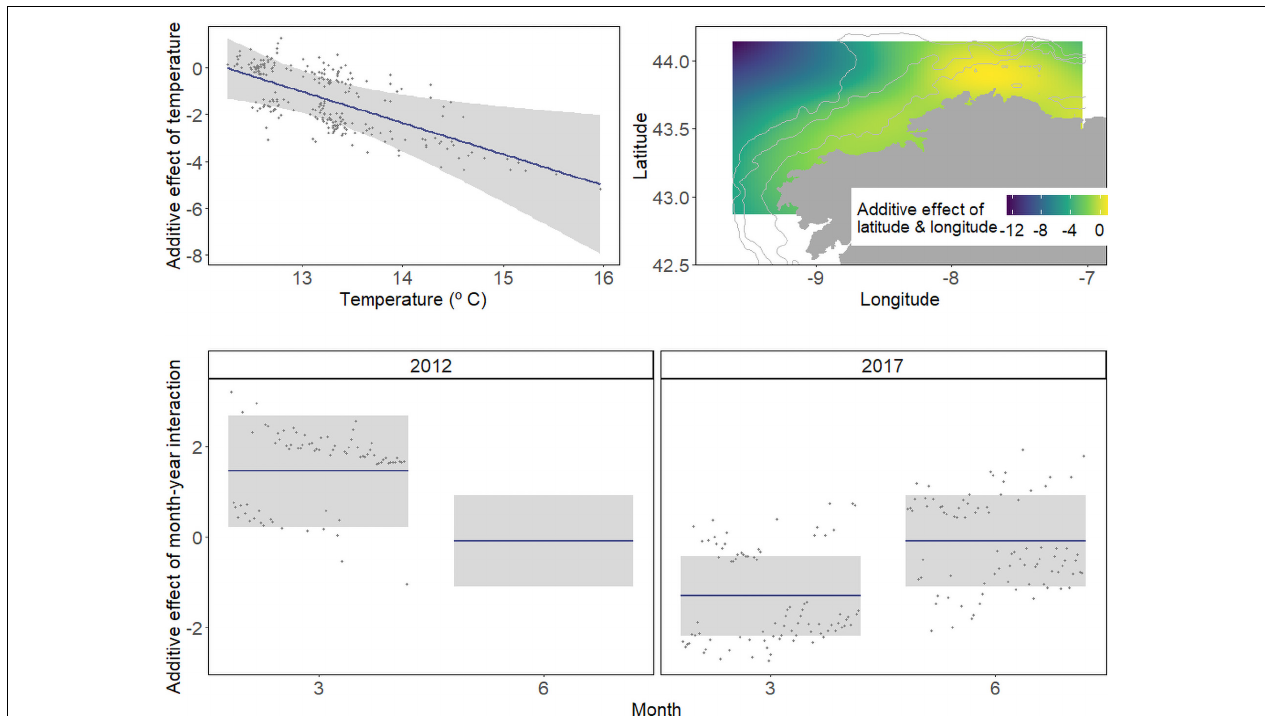
FIGURE 3 | Response plots for abiotic variables on the partial effects of the P/A of hake larvae from final generalized additive models (GAMs). The plot includes the additive effect of temperature at 50 m and spatial (latitude-longitude interaction) and temporal effect (year-month interaction) on hake larvae occurrence. Solid lines denote smoothed values, and shaded areas represent 95%